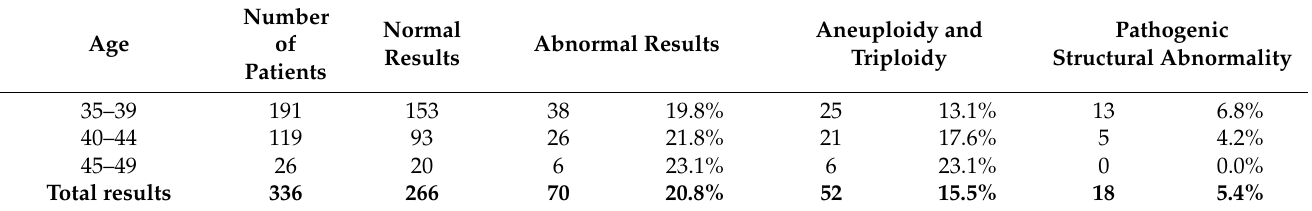
Table 3. The aCGH results of 336 samples with indication of advanced maternal age.